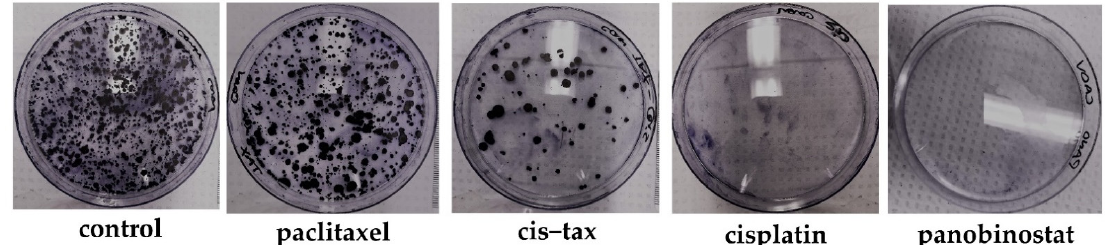
Figure 11. Cancer colony formation of Caov-3 cells derived from spheroids following initial treatment in a 3D environment. One hallmark of aggressive recurrent cancer is the potential formation of cancer cell colonies, because these cells have the unique ability to seed and colonize a new environment. Therefore, we replated Caov-3 spheroid-derived cells previously treated with a DMSO control, paclitaxel, cisplatin, cis–tax and panobinostat. Cells previously exposed to paclitaxel formed colonies with a density similar to the control. Cells exposed to cisplatin and cis–tax grew substantially fewer colonies, whereas no colonies are visible with cells treated with panobinostat ( n = 3).